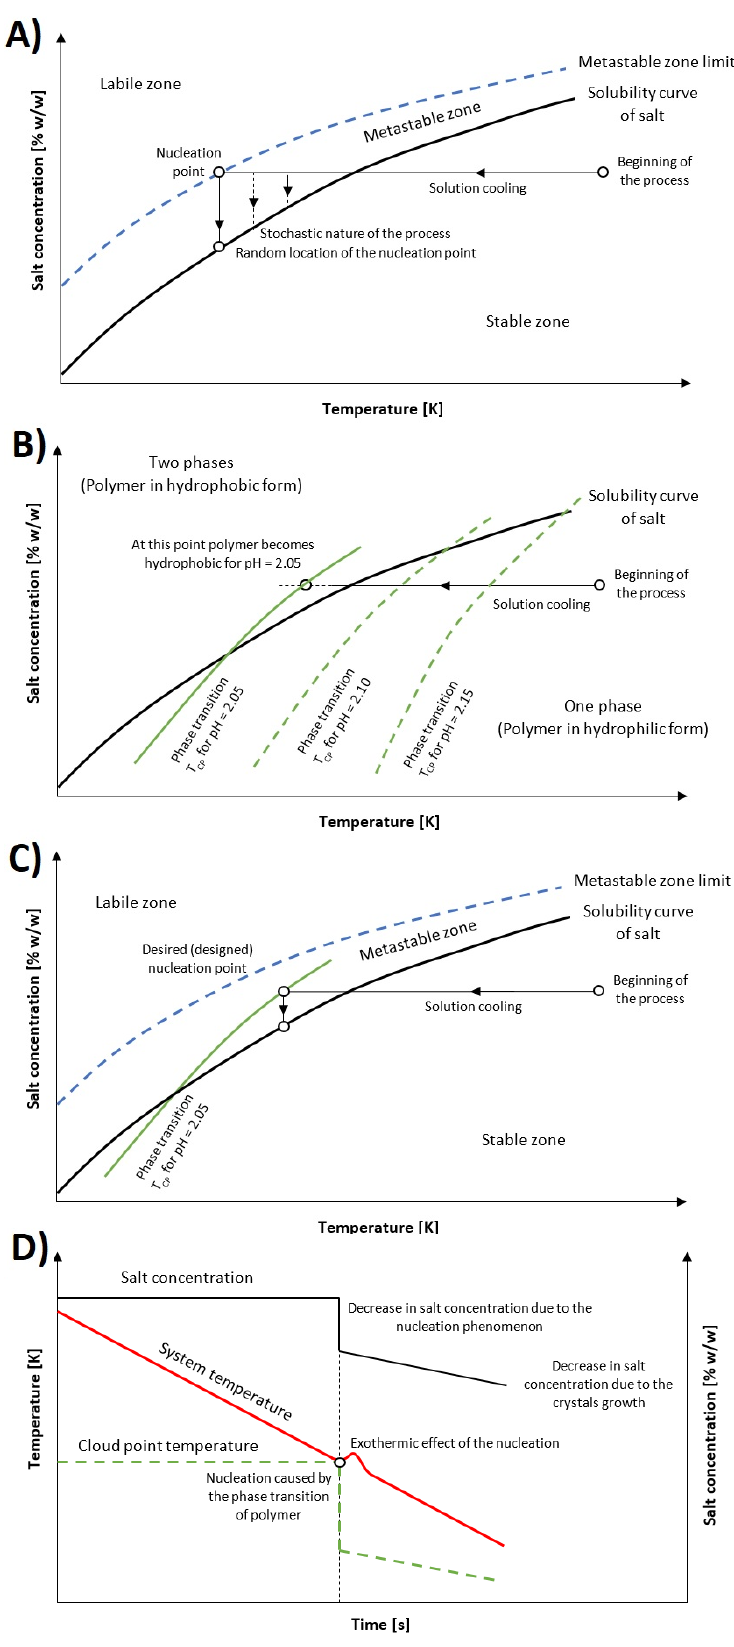
Figure 1. Proposed mechanism of crystallization: ( A ) standard crystallization; ( B ) phase transition of polymer, ( C ) combination of the processes, ( D ) process course in time.